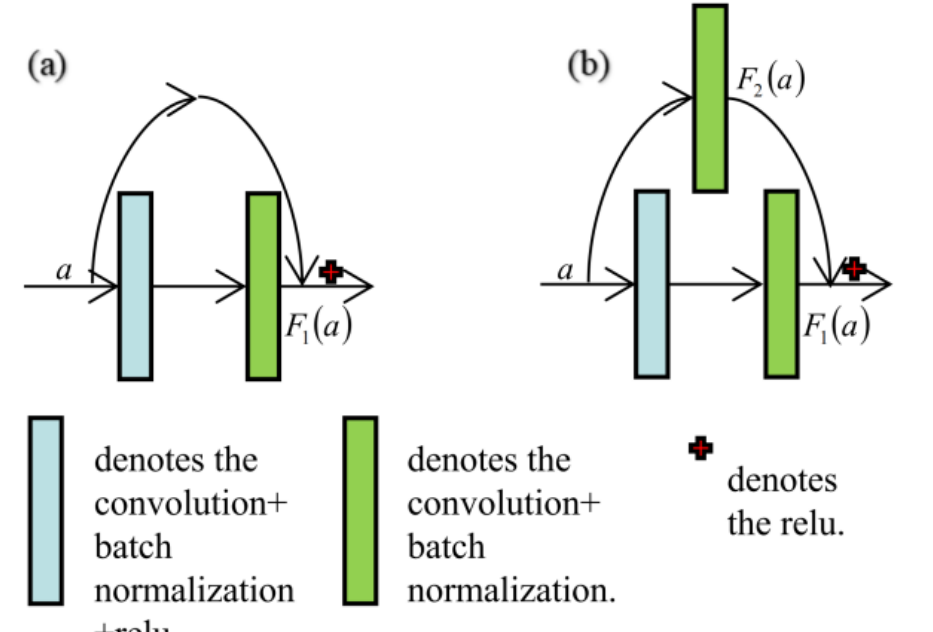
Figure 1. Skip-connection block in the ResNet: ( a ) identity block; ( b ) convolution block.